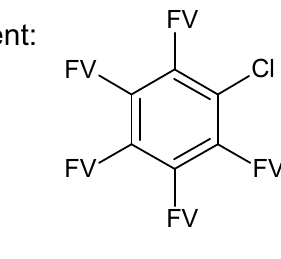
Figure A4. Substructures for GC–MS Challenge 5. FV = free valence.